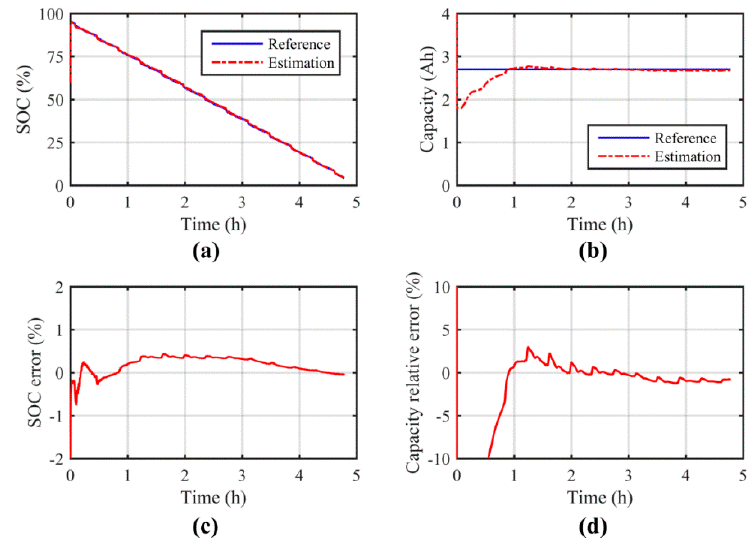
Figure 7. Estimation results of SOC and capacity under the FUDS simulation study: ( a ) estimation of SOC; ( b ) estimation of capacity; ( c ) error of SOC estimation; ( d ) relative error of capacity estimation.